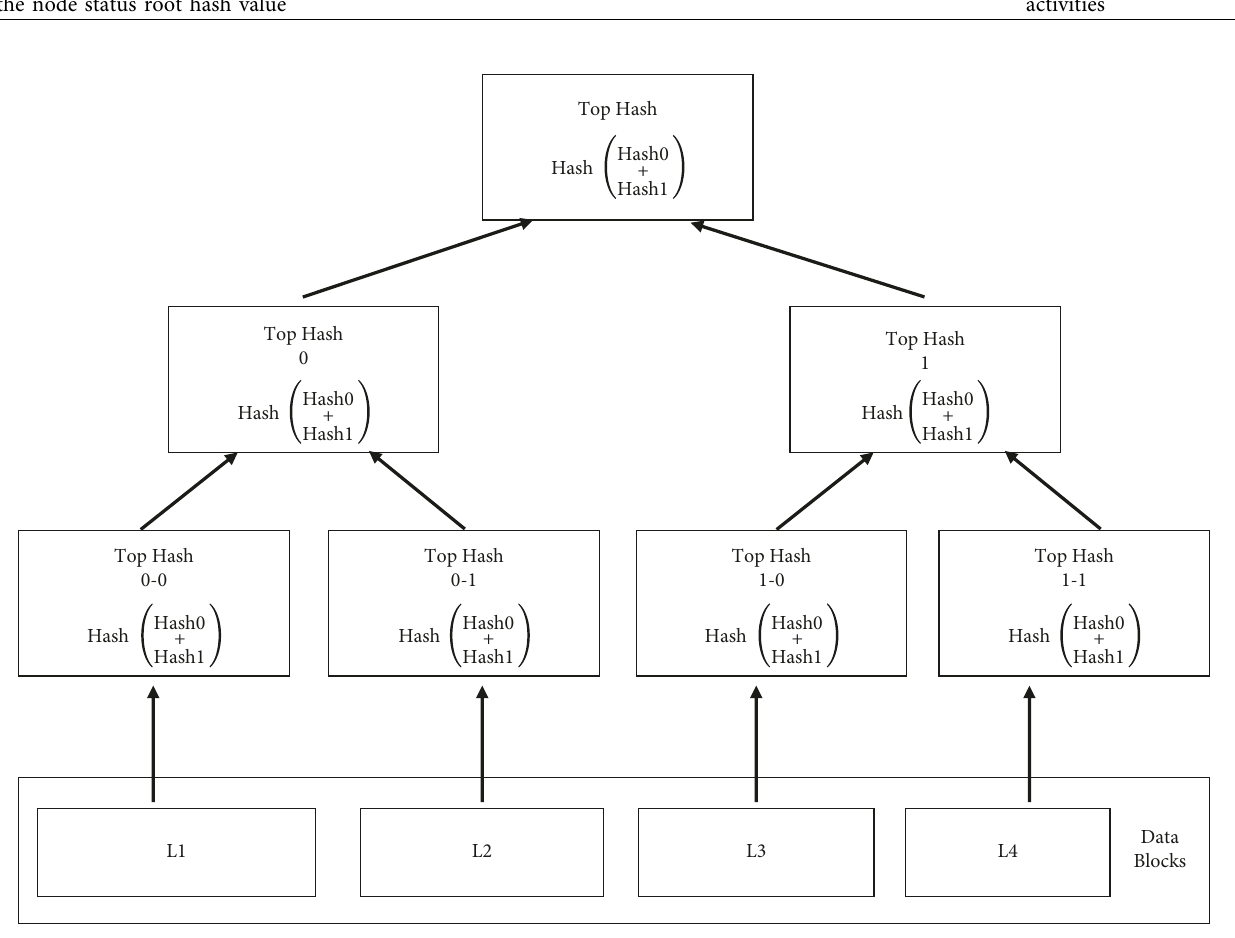
Figure 1: Merkle tree